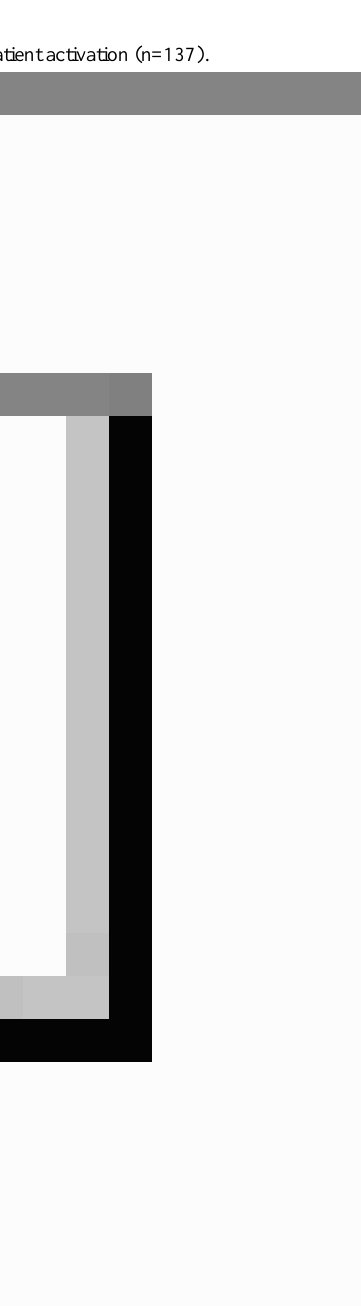
regression estimates (linear predictions) for change in patient activation by patient activation level at baseline. The most notable difference between the intervention and control groups was among patients starting from the highest level of patient activation (marginal effect=4.82, P =.13; Figure